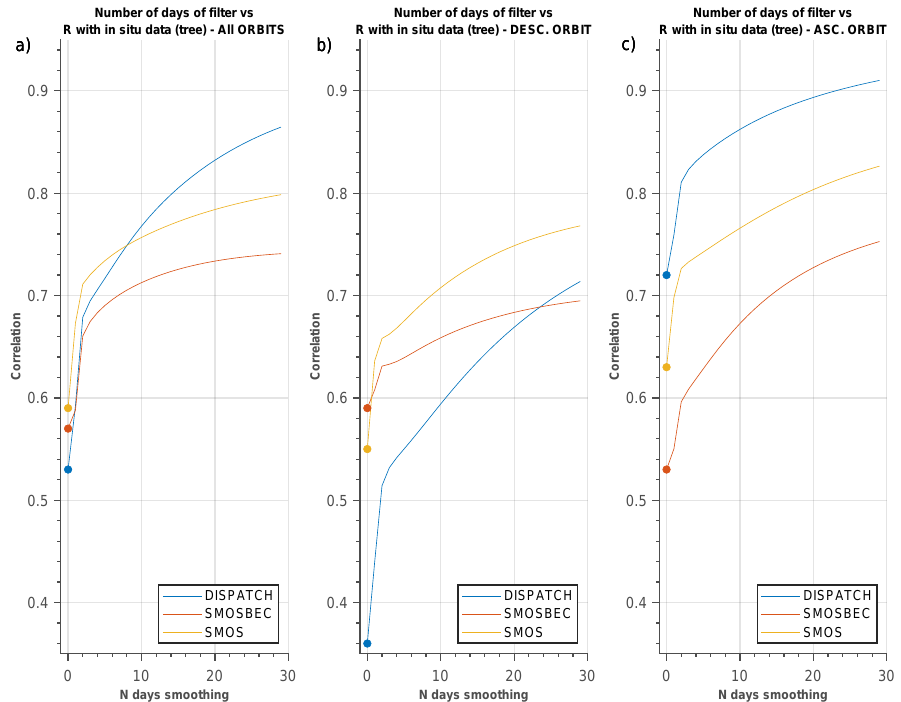
Figure 7. Correlation (y-axis) between the in situ (tree measurements) and satellite-based soil moisture (SBSM) records using a low-pass filter of different frequencies (x-axis). DISPATCH (blue), SMOS-BEC (red), and SMOS (yellow) using all orbits ( a ), descending ( b ), or ascending ( c